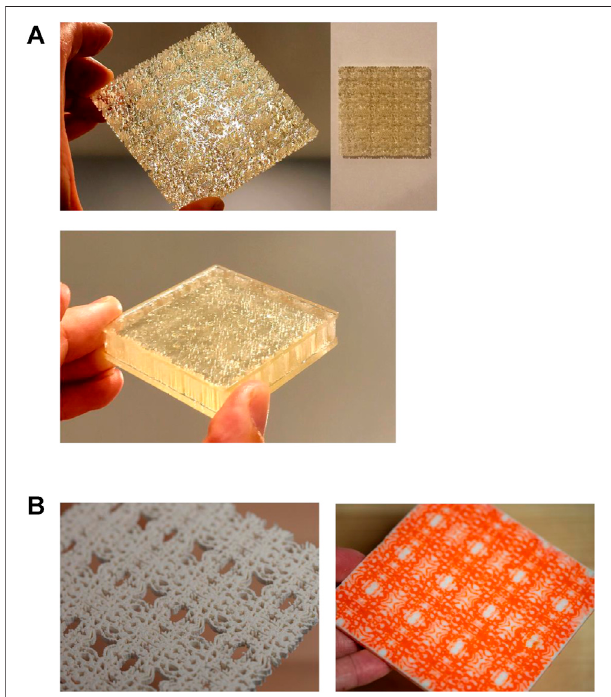
FIGURE 6 | SLA resin (A) and Fused Deposition Modeling (FDM) (B) basedrealizationsofthearchitectedmaterialshownin Figure4 .Thedesignin the top row of panel A is generated without a covering layer, whereas the design on the bottom re fl ects a sandwich design (a fl at top/bottom layer is added to mimic a sandwich material design). The results in panel B show both a single material print (left) and a multimaterial print (orange (cid:1) soft material, white (cid:1) rigid